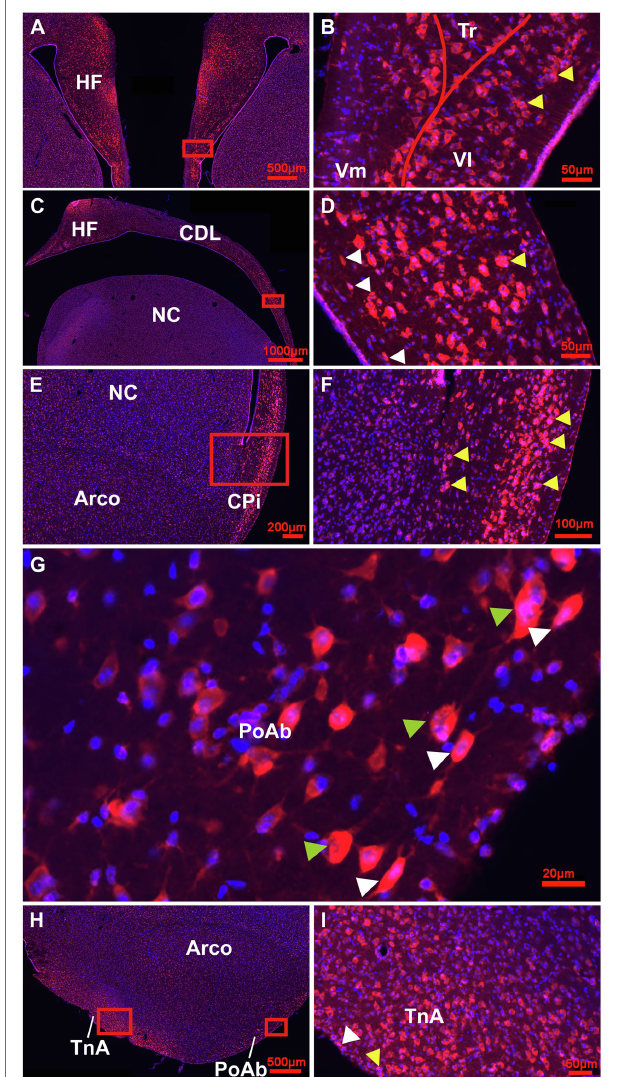
FIGURE 4 | Detailed overview of Tbr2+ cells in the adult pigeon forebrain. (A) Detail of the HF at atlas level A8.00 showing intense labelling of Tbr2 + (red)/ Hoechst+(blue), i.e., double labelled pinkish cells in the DMd region and V-region of the HF. (B) Magnification of the Box in (A) showing a different cellular location of Tbr2+ cells in the V-region with high densities in VL (stage 2–3) and the ventricular zone (stage1). Cell clusters of stage 2 are indicated by yellow arrowheads. (C) Detail of the HF and CDL at atlas level A.6.00 with pinkish TBr2+/Hoechst+ cells accumulated in DMd and ventral CDL shown enlarged from the box in (D) . Here, white arrowheads indicate migrating cells of stage 3 and yellow arrowheads cell clusters of stage 2 (D) . (E) Detail of Tbr2+ expression in CPi cells, enlarged in (F) . Yellow arrowheads indicate cell clusters at both sides, close to ventricular zone and to the granular layer of the Cpi, which is close to pial surface (F) . (G) High magnification image of Tbr2+/Hoechst+ cells of stage 2 cloudy (mitotic) cells, indicated by green arrowheads and stage 3 migrating (ovoidal) cells, indicated by white arrowheads along the outer band of PoAb (position of box in H ). (H) Detail of Tbr2+ expression at the level of TnA, PoAb and Arco that is enlarged for TnA in (I) . (I) Tbr2+/Hoechst+ cells in TnA showing stage 2 cluster cells (yellow arrowhead) and stage 3 ovoidal, migrating cells (white arrowhead). Generally, Tbr2 is found in the cell somata, but is also present in the nuclei, particularly in the small cells of the ventricular zones (double-labelled cells Tbr2+/Hoechst+ appear